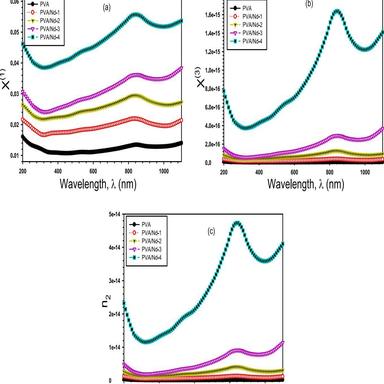
(a) X(1), (b) X(3), and (c) n2 with λ for PVA and PVA/Nd2O3.